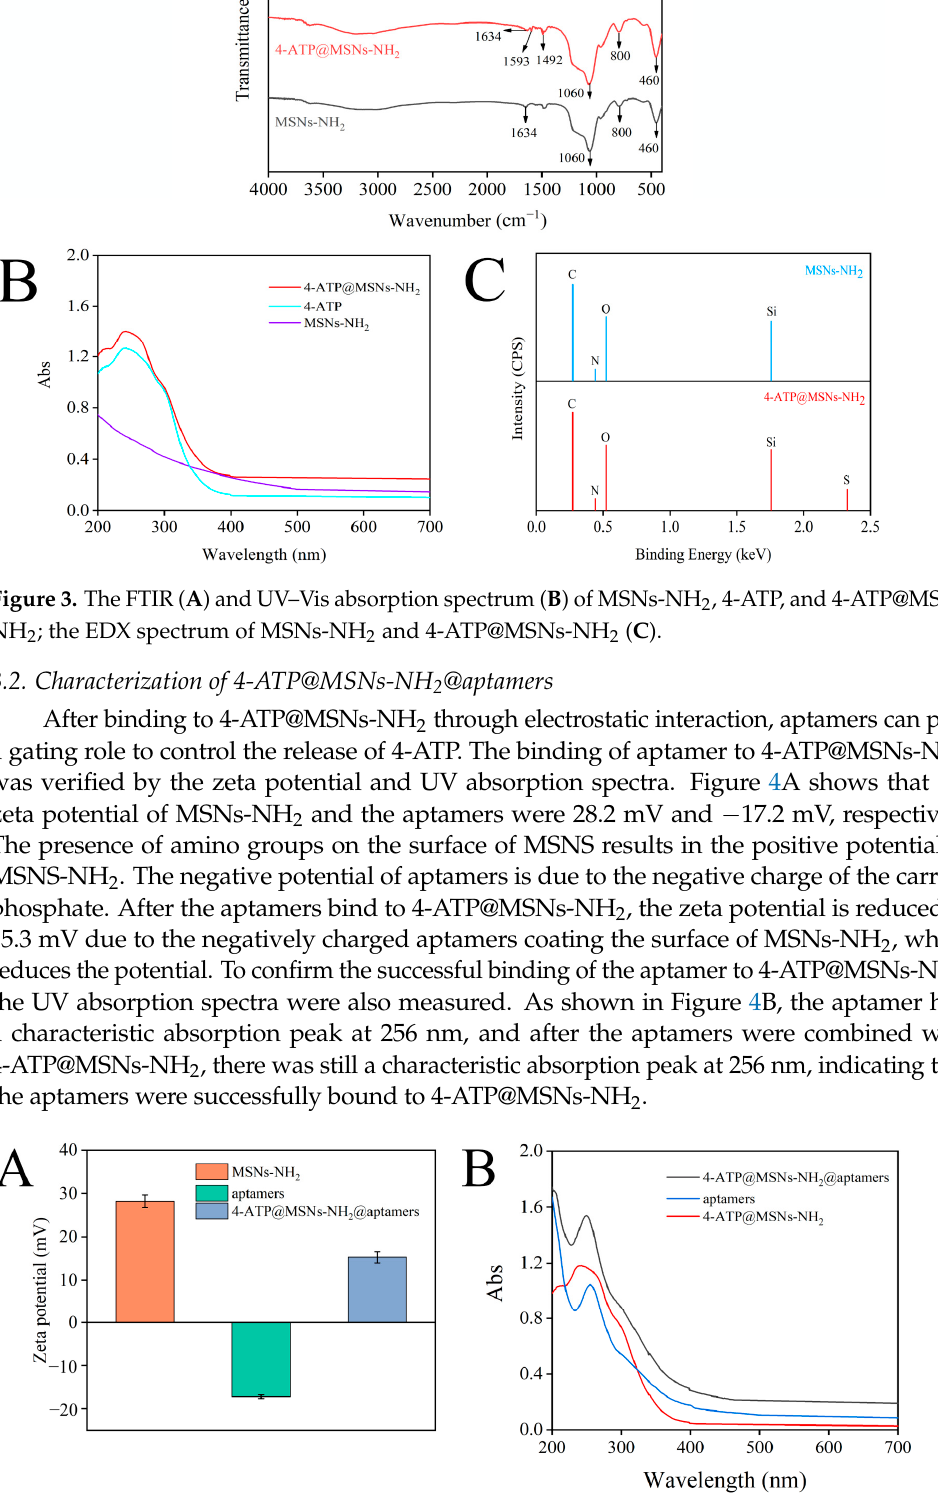
Figure 4. The zeta potential of MSNs-NH 2 , aptamers and 4-ATP@MSNs-NH 2 @aptamers ( A ); the UV − Vis absorption spectrum of ATP@MSNs-NH 2 @aptamers, aptamers, and 4-ATP@MSNs-NH 2 ( B